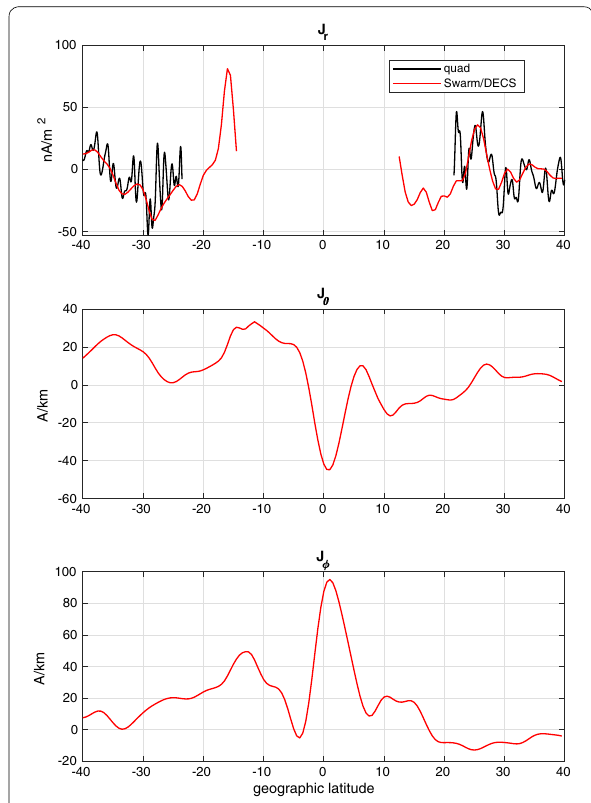
Fig. 7 Event E2. Latitude profiles of the the current components between the Swarm-A/C satellites obtained from the Swarm/DECS analysis. Black solid line in the upper panel shows the radial current from the quad method (Ritter et al.